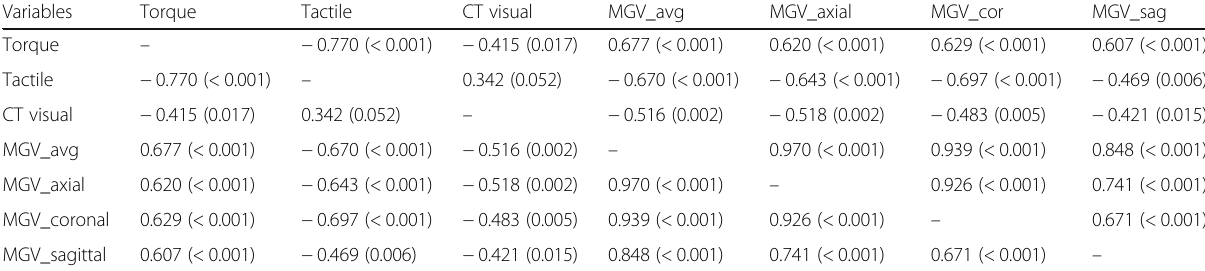
Table 2 Matrix of Spearman correlation coefficients and P values (in brackets) for the association among assessment methods of bone quality (intra-surgical tactile perception, preoperative CT visual evaluation, preoperative CT mean gray values (MGVs)) and